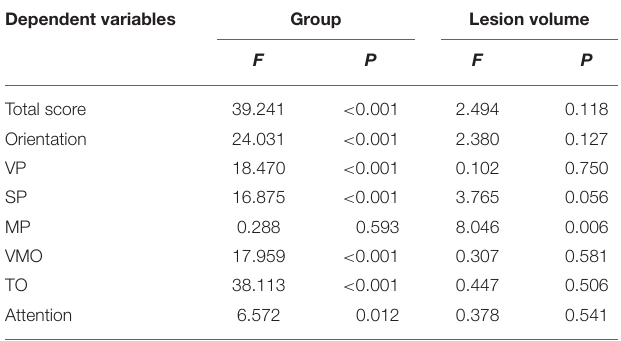
TABLE 3 | The effect of lesion volume on the difference of LOTCA scores between PSA group and non-PSA group. Dependent variables